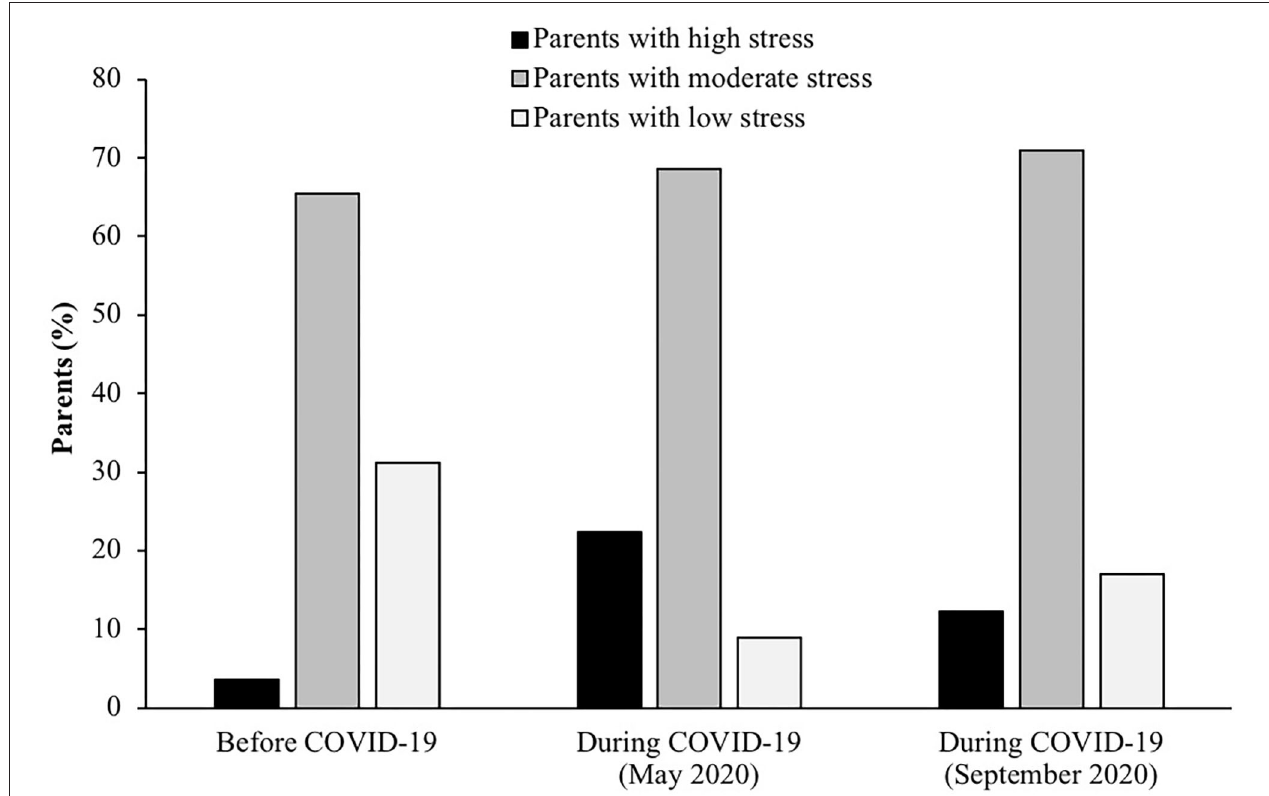
FIGURE 1 | Percentage of parents with high, moderate, and low stress based on the Perceived Stress Scale, reported retrospectively for before COVID-19, and concurrently during COVID-19 in May and September 2020. Data were collected in a nationwide sample of US parents with a child 5–18 years of age ( N =